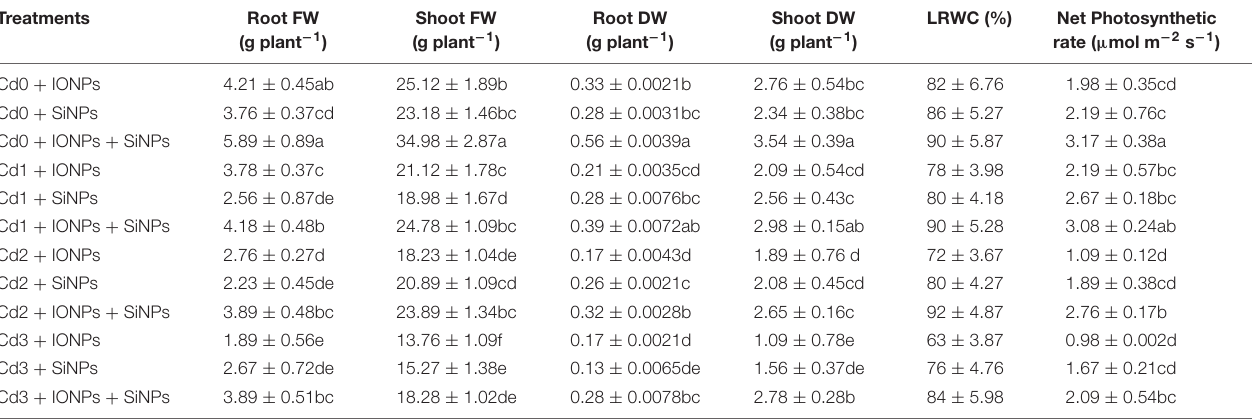
TABLE 1 | Effect of IONPs and SiNPs on root fresh weight, shoot fresh weight, root dry weight, shoot dry weight, leaf relative water content, and net photosynthetic rate of Phaseolus vulgaris grown in different concentrations of Cd.